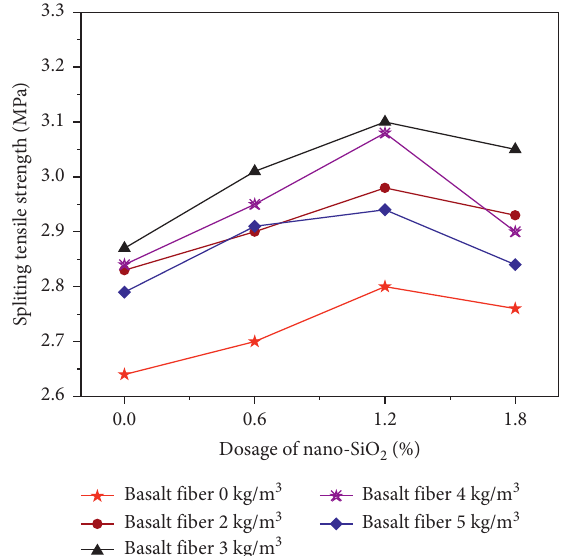
Figure 13: Effect of the NS dosage on the splitting tensile strength